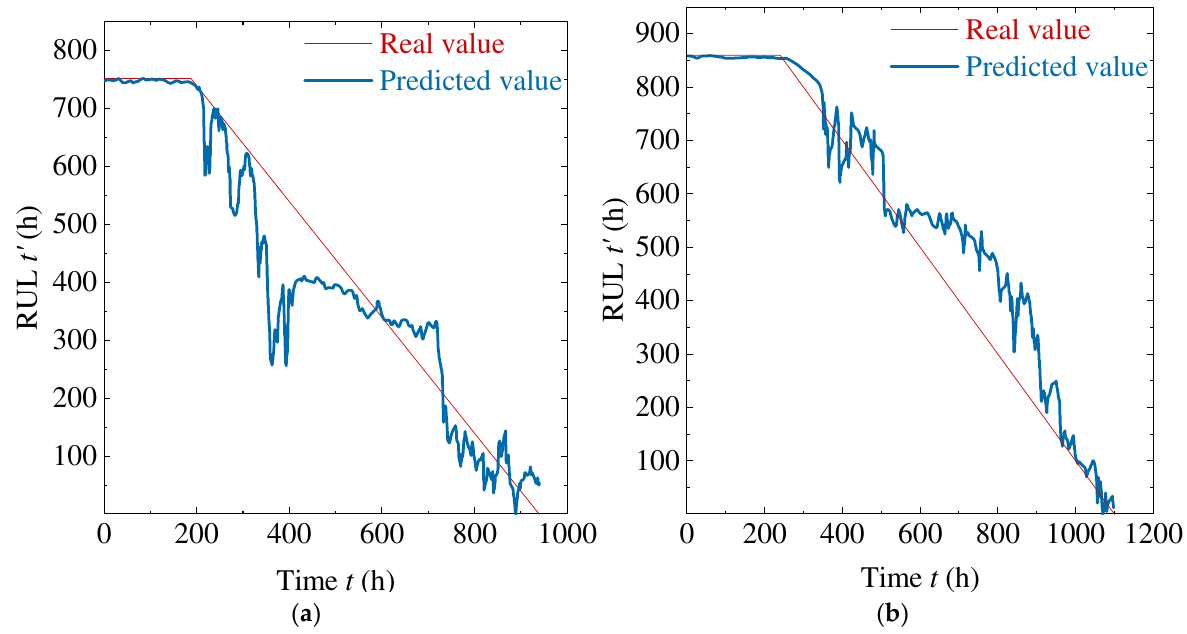
Figure 21. Predicted and actual RUL curves. ( a ) Description of curves for pump 3; ( b ) description of curves for pump 4.